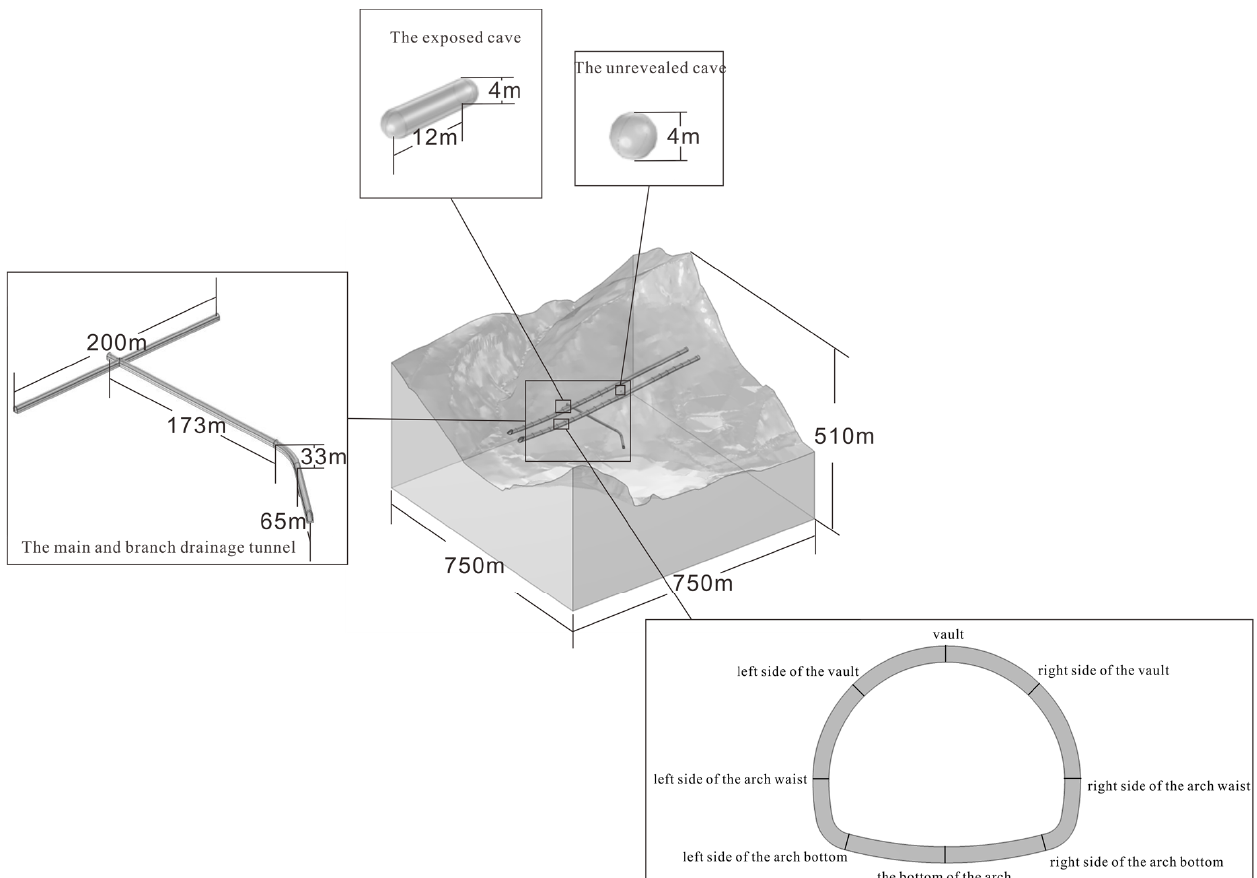
Figure 12. 3D geological model.